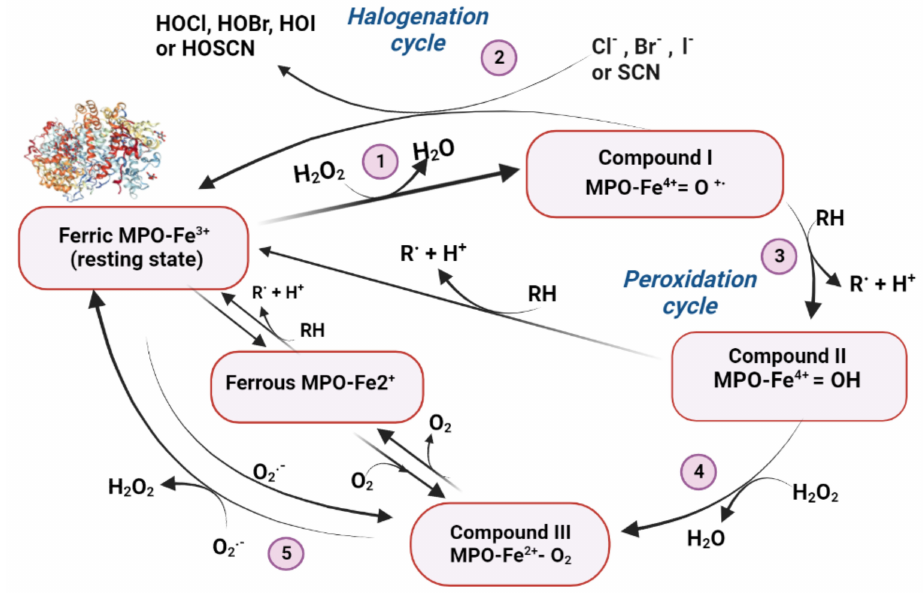
Figure 3. The myeloperoxidase (MPO) catalytic cycle. Ferric myeloperoxidase (MPO-Fe3+ in its resting state) reacts reversibly with hydrogen peroxide by oxidation of the heme group and formation of the ferryl-p cation radical intermediate compound I (1). This intermediate can oxidize halides and the pseudo-halide thiocyanate to the corresponding hypohalous acids, while being readily reduced to MPO-Fe 3 + (2). Compound I also oxidizes multiple organic substrates (RH) to free radicals (R.) in the classical peroxidase cycle which involves two sequential one-electron reduction steps, generating compounds II (3) and III (4). Peroxidation substrates include tyrosine estradiol, serotonin, norepinephrine, ascorbate, urate, etc. Superoxide can also be the substrate for compound I and compound II in these stages. Ferric myeloperoxidase can be reduced to its ferrous form MPO-Fe 2 +, which binds to O 2 , forming the oxymyeloperoxidase, or compound III (MPO-Fe 2 +O 2 ). Superoxide also provides the substrate for the fast conversion of the ferric enzyme to form compound III